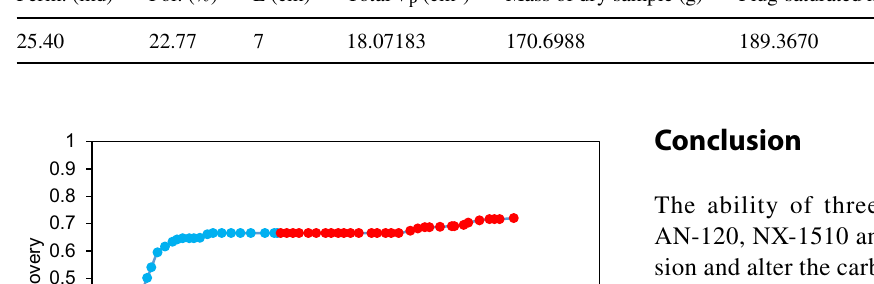
Table 8 Plug specifications used in flooding tests Perm. (md)